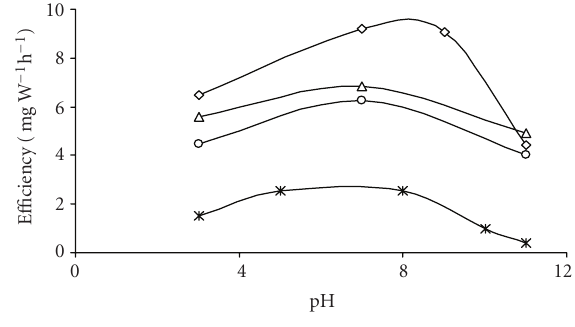
Figure 2: The dependence of PCO e ffi ciency of lignin on pH with di ff erent photocatalyst application mode: plate 0.75 mg cm − 2 (spraying) ( (cid:3) ), plate 0.7mg cm − 2 (submersion) ( Δ ), plate 0.3 mg cm − 2 (submersion) ( ◦ ), micro-spheres 25g m − 2 ( ∗ ); initial concentration of lignin 100 mg L − 1